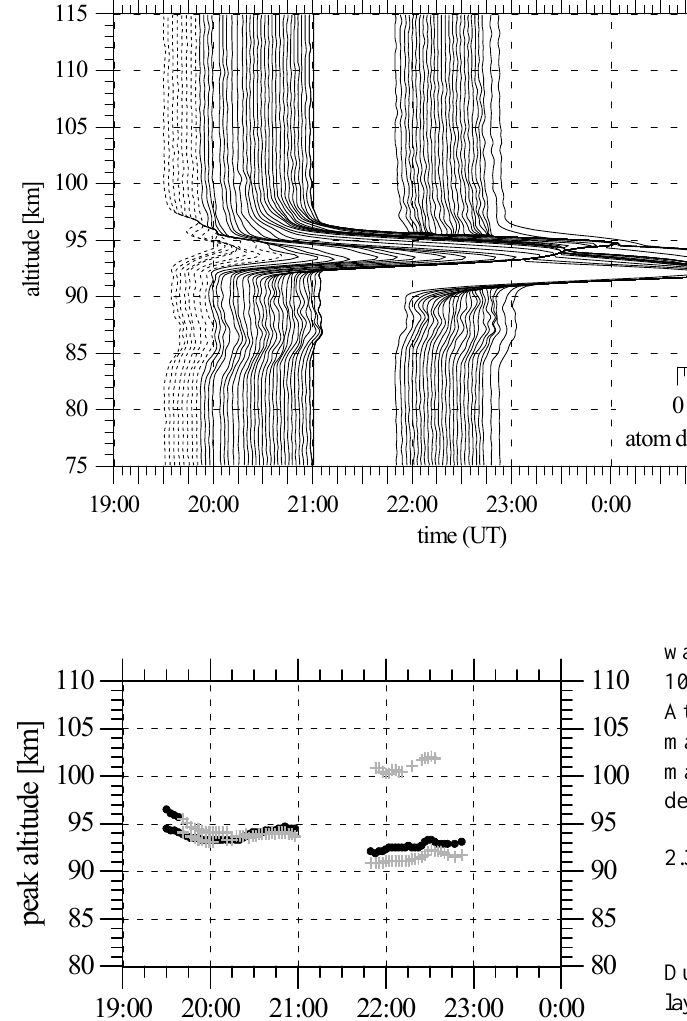
Fig. 2. Altitude variation of the sporadic Ca s (dots) and Ca + s (crosses) around 95 km in the evening of April 7,